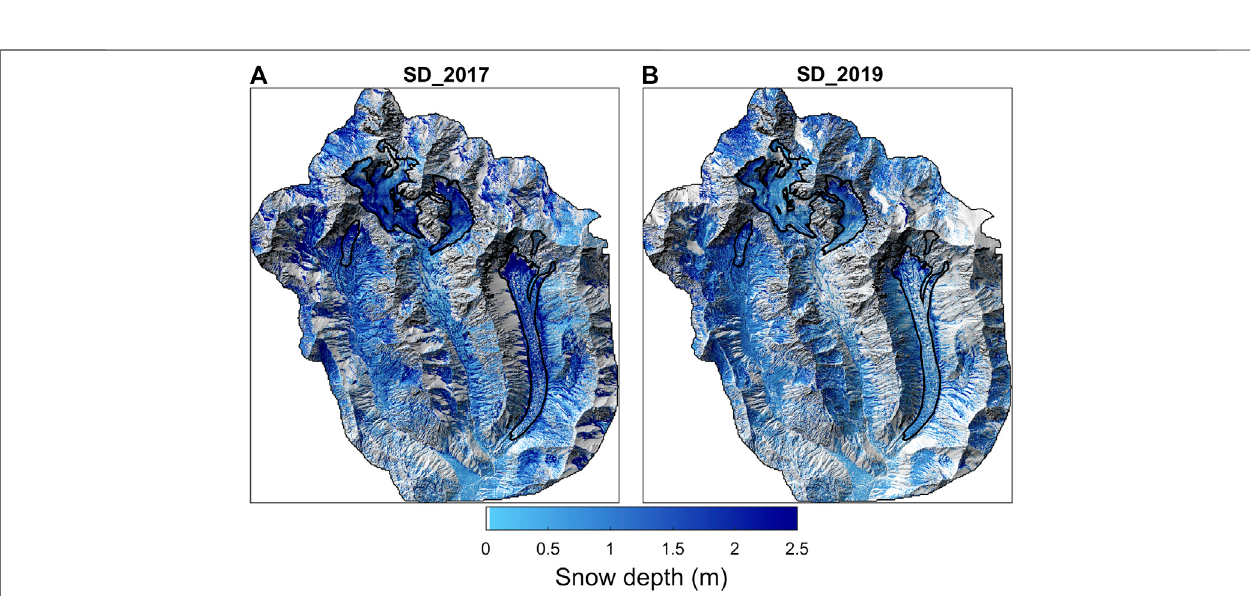
FIGURE5| Theevaluationofdigitalelevationmodel(DEM)differencingoverstableterrainfor2017 (A) ,2019 (B) and2019 – 2017(d 2 DEM-C).Scalesarelimitedto − 1 to +1 m for visualisation purposes. Panel C) shows the empirical cumulative distribution function with an alpha value of 25% (related to a 25 – 75th percentile). The shaded grey area represents the uncertainty band for all mutually stable terrain pixels in both years.